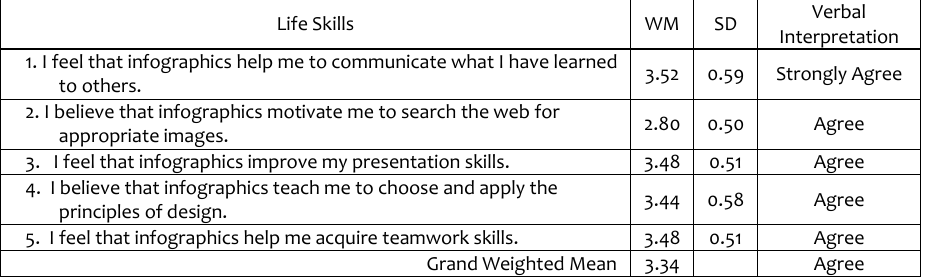
Table 4: Respondents’Perception of the Impacts of Infographics in Terms of Life Skills Development Life